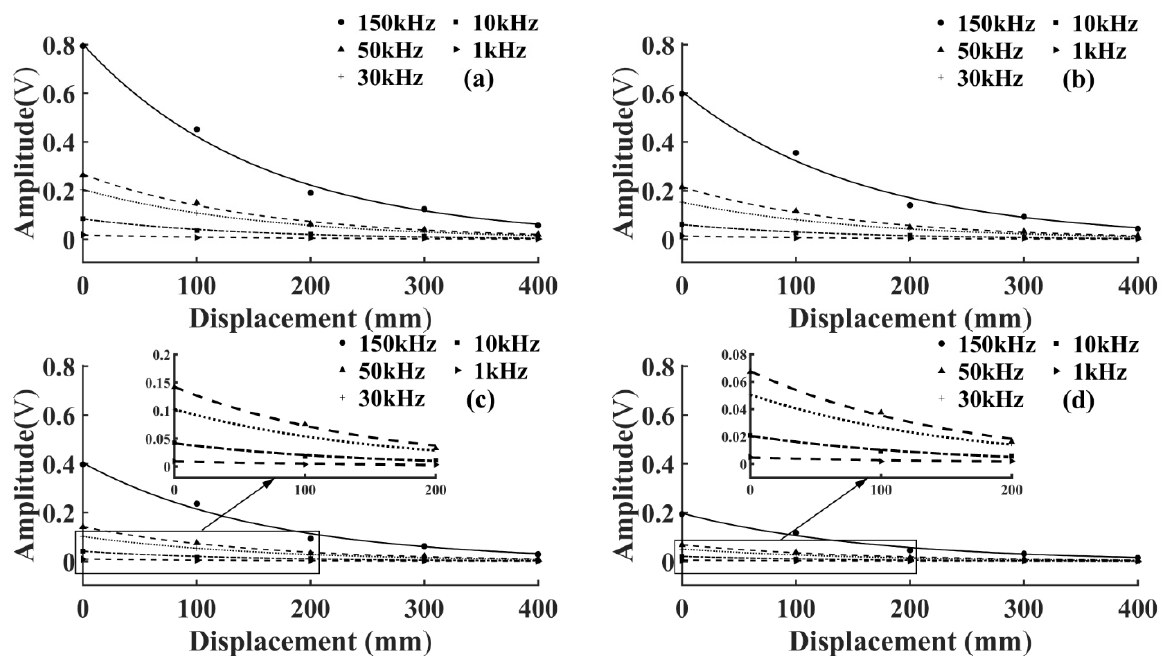
Figure 3. Fitting curve of AE signal amplitude attenuation of T1 specimen. ( a ) Voltage level 20 V;